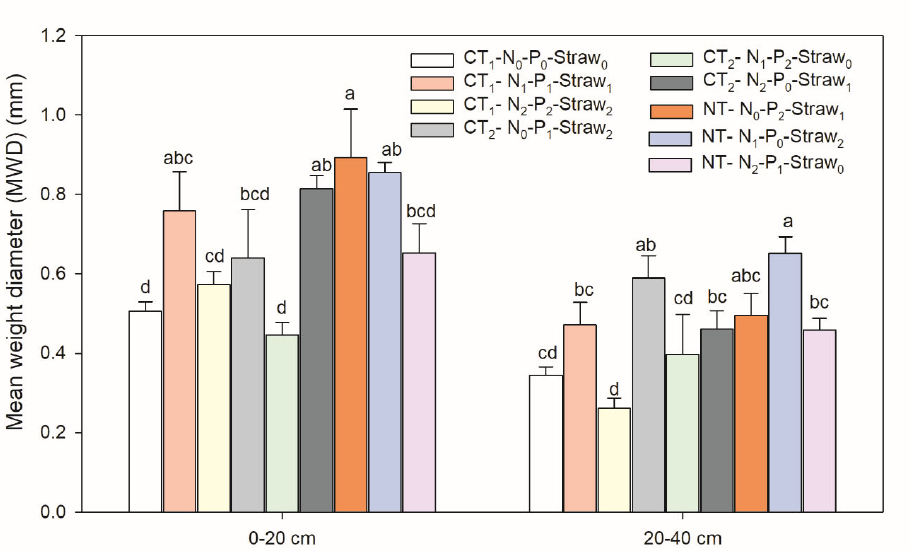
Figure 4. The mean weight diameter (MWD) of different tillage management and fertilization at 0–20 and 20–40 cm. Bars followed by similar letters between treatments within a soil layer are not significantly different according to Tukey’s HSD test. CT 1 turned straw into the soil and CT 2 covered straw on the surface.